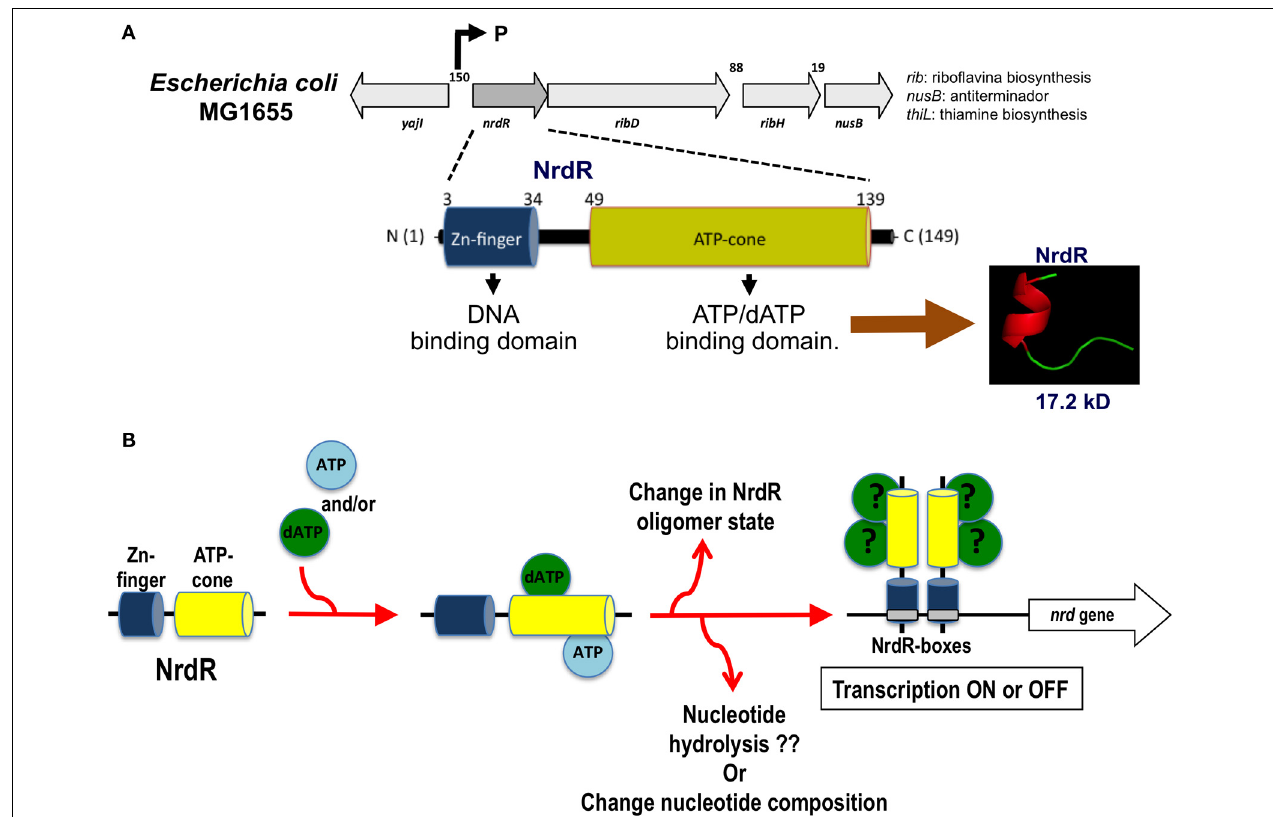
FIGURE 4 | nrdR operon organization and hypothetical mechanism of transcription regulation by NrdR. (A) Structure of the nrdR operon and functional protein domains for the NrdR transcriptional regulator. (B) Hypothetical mechanism for the transcriptional regulation